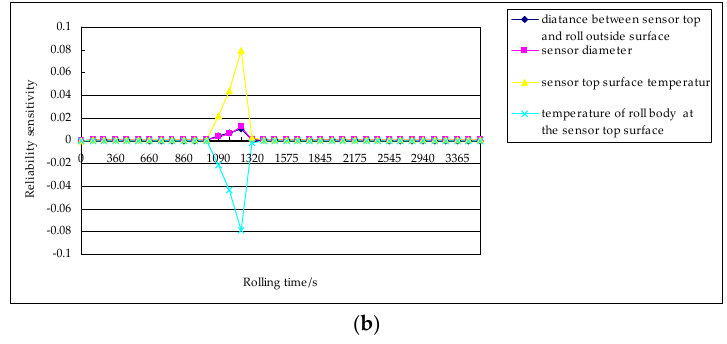
Figure 10. Reliability sensitivity analysis of the mean values of the variables: sensitivity analysis of the ( a ) initial interference; ( b ) other